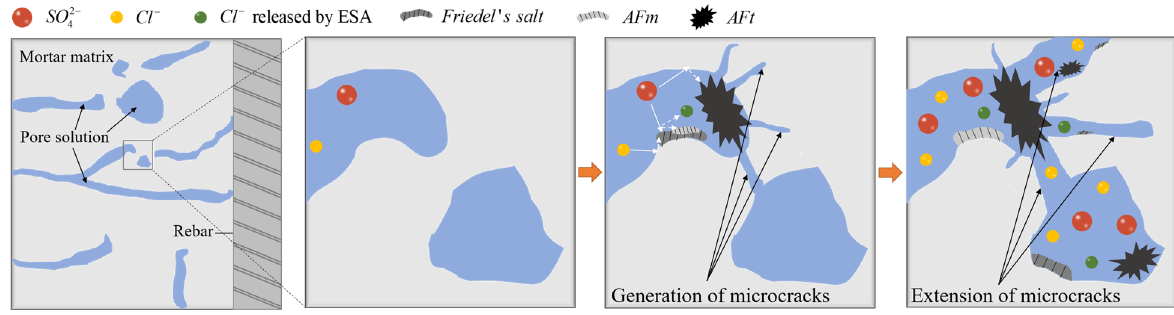
Figure 6. Schematic diagram of the competitive antagonism during the combined chloride ‐ sulfate attack. Adapted from